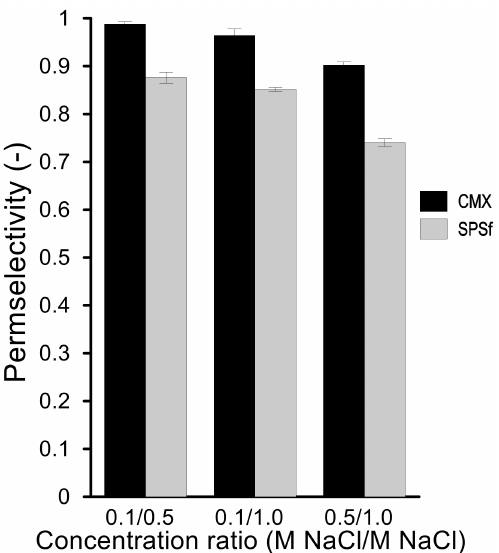
Figure 12. Permselectivity of CMX and SPSf exposed to different NaCl solution pairs.